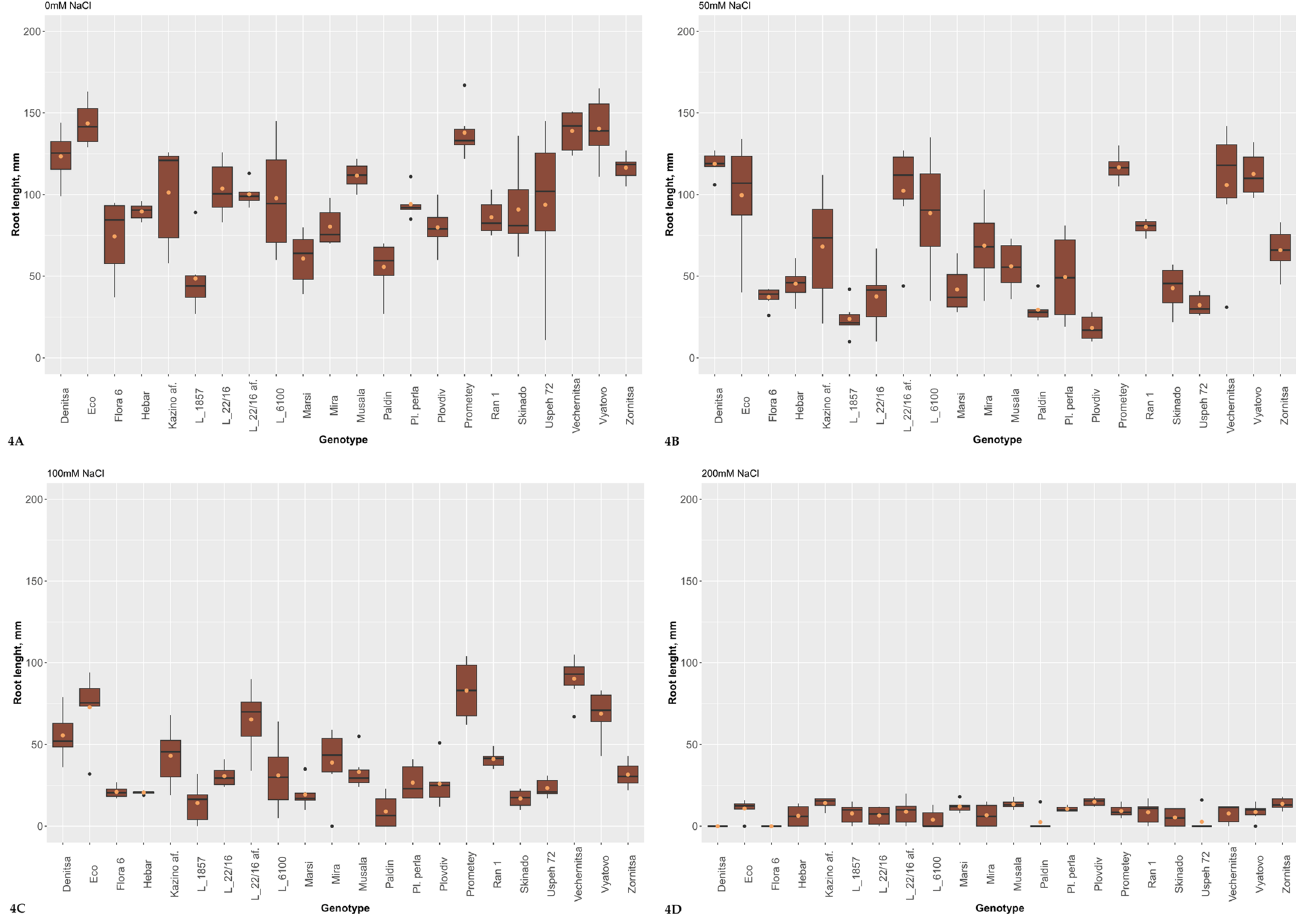
Figure 3. Shoot length (mm) of 22 garden pea genotypes as influenced by the concentration of NaCl in nutrient medium in vitro after 14 days of cultivation. ( A ) 0 mM NaCl; ( B ) 50 mM NaCl; ( C ) 100 mM NaCl; ( D ) 200 mM NaCl.